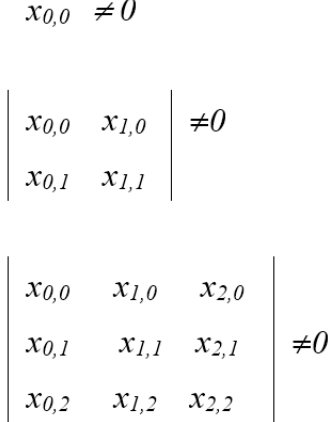
Figure 7. Determination of matrix elements of a parametric operator h